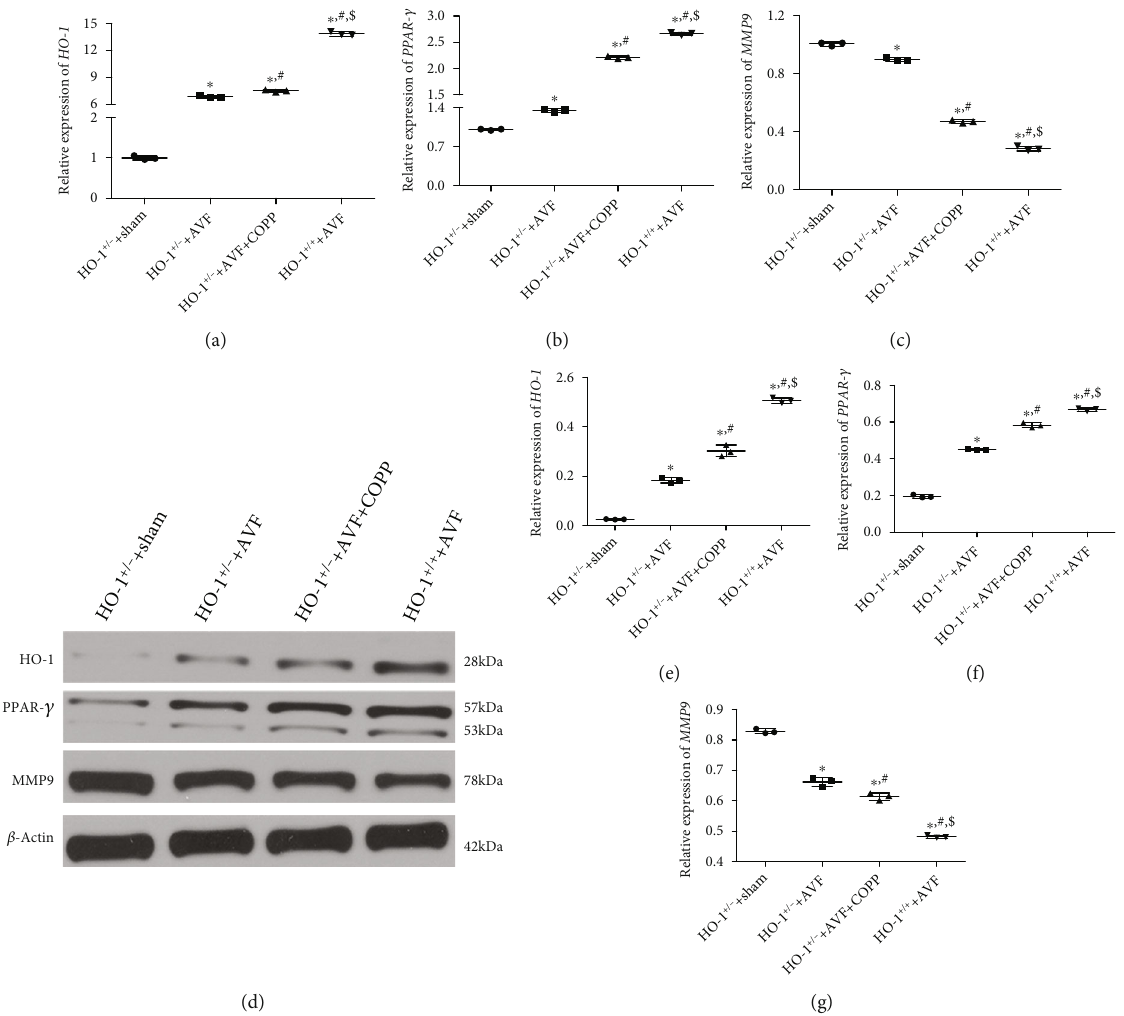
Figure 6: E ff ects of HO-1 knockdown on the expression levels of HO-1, PPAR- γ , and MMP9. The relative mRNA expression of HO-1 (a), PPAR- γ (b), and MMP9 (c) in di ff erent groups determined by RT-qPCR. (d) The protein bands visualized by western blot. The relative protein expression of HO-1(e), PPAR- γ (f), and MMP9 (g). ∗ P < 0 : 05 , compared with the HO-1 +/- +sham group; # P < 0 : 05 , compared with the HO-1 +/- +AVF group; $ P < 0 : 05 , compared with the HO-1 +/- +AVF+COPP